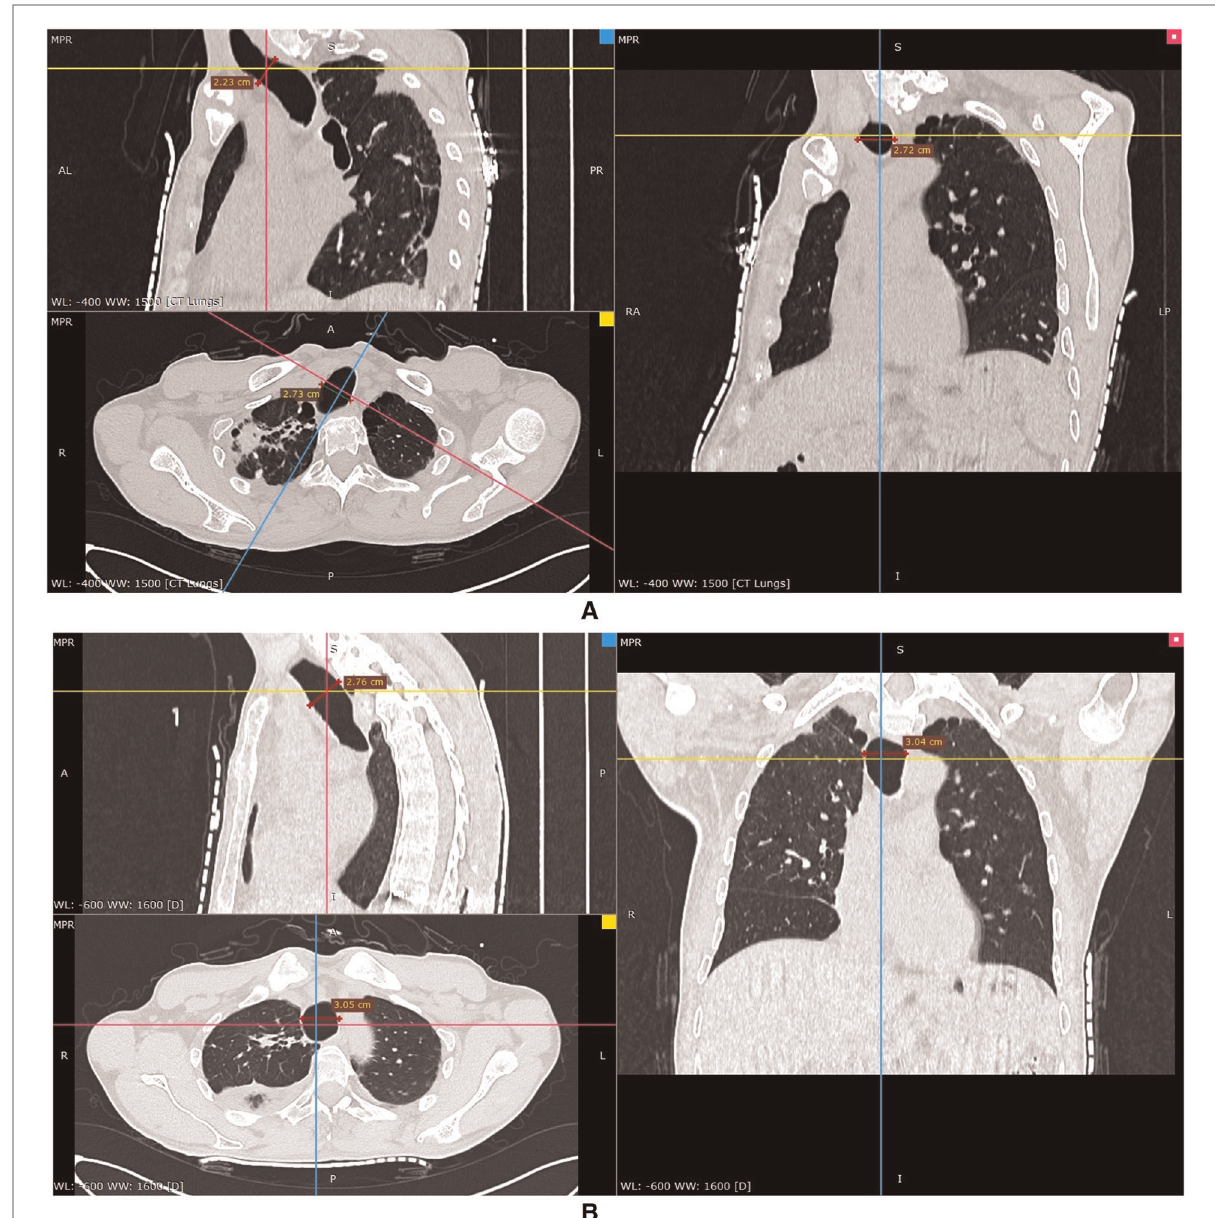
FIGURE 2 CT images of the lung demonstrating an enlarged trachea on the level of 2 cm above the aortic arch. The axial image (down-left) and coronal image (right) showed that the diameter of the trachea was 27.2 mm. The sagittal diameter (up-left) of the trachea was 22.3 mm ( A ). CT images of the lung on the level of the aortic arch, where the diameter of the trachea was the longest. The transverse diameter on the down-left axial image was 30.5 mm. The diameter on the right coronal image was 30.4 mm. Also, the sagittal image (up-left) demonstrated that the diameter of the trachea was 27.6 mm ( B